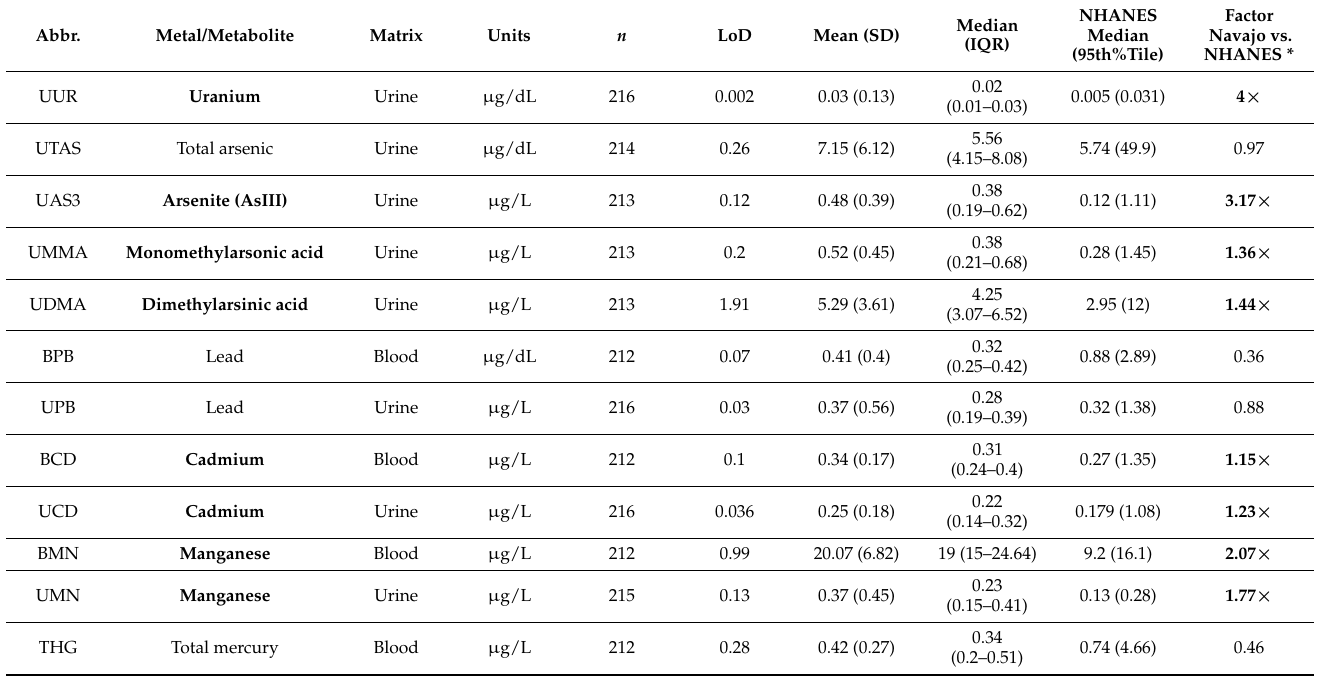
Table 2. Summary statistics for concentrations of exposure biomonitoring, including limit of detection